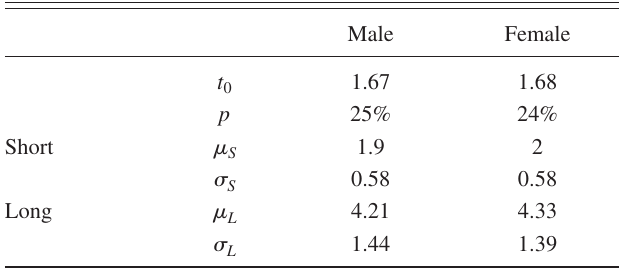
TABLE II. Parameters obtained from independent minimum- (cid:4) 2 fits of Eq. (cid:1) 3 (cid:2) to the data (cid:1) Fig. 6 (cid:2)